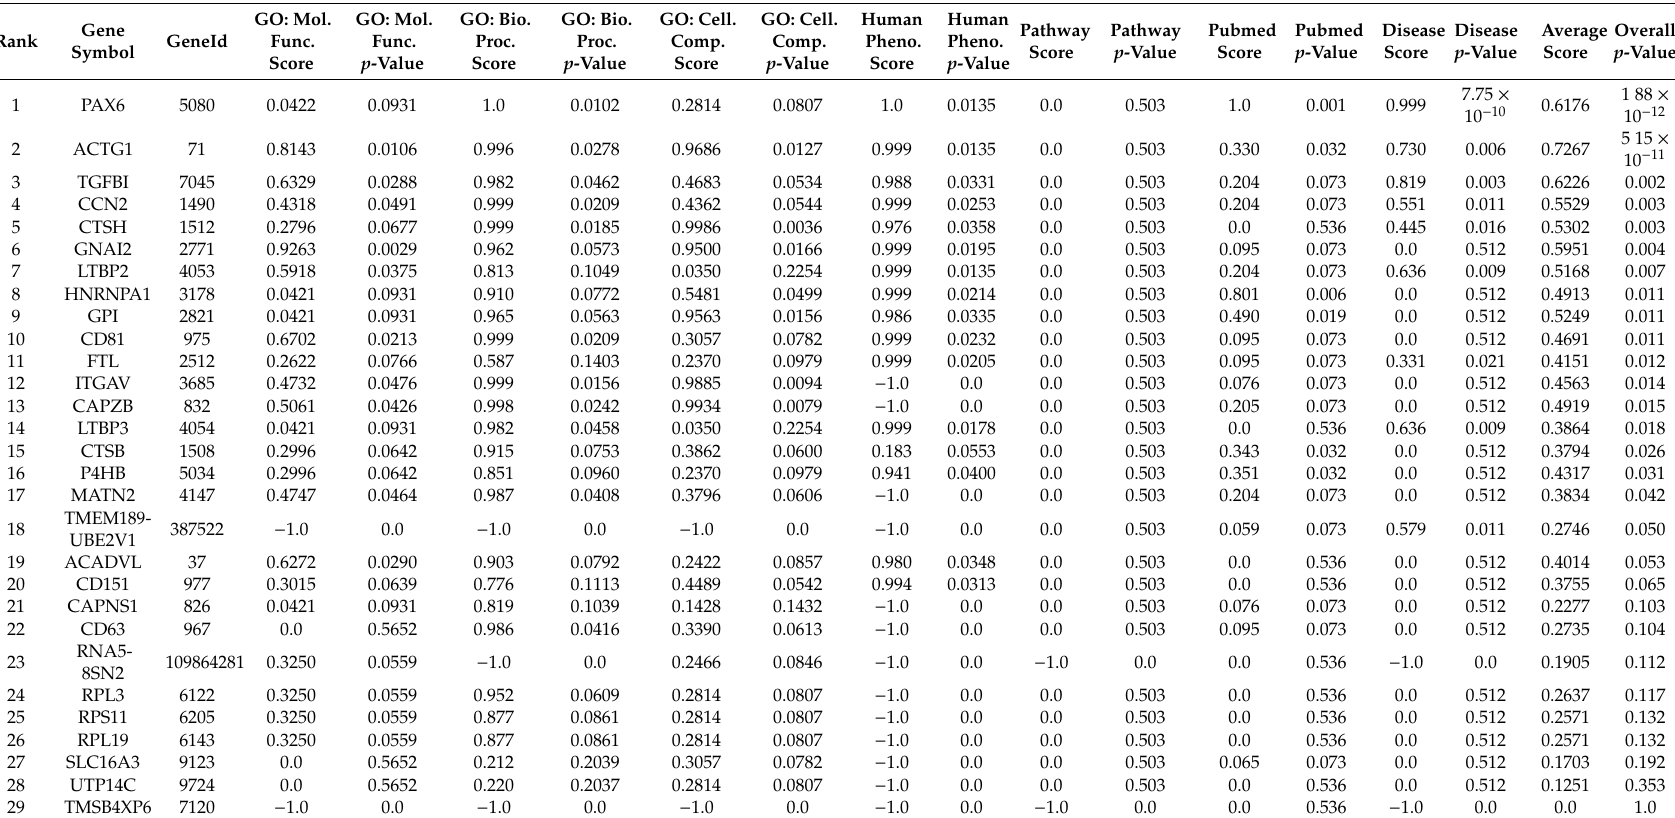
Table 1. ToppGene prioritization analysis results. The ToppGene prioritization analysis on known causative retinal dystrophy genes that intersected with most significant DE and DAS genes obtained during the whole transcriptome analysis revealed 19 candidate genes (Bonferroni corrected p -value < 0.05), of which seven had a strong association with training genes (Bonferroni-corrected p -value < 0.01). All shown p -values are